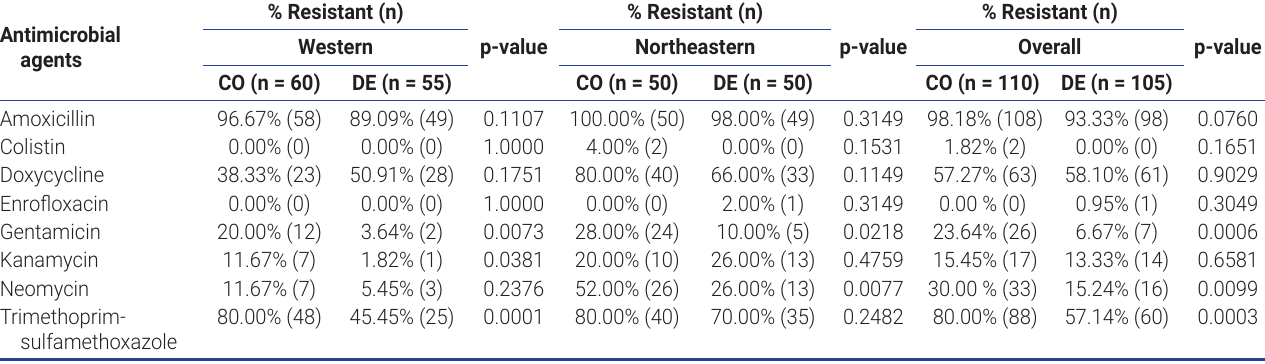
Table 2. Percentages of antimicrobial-resistant Escherichia coli between the conventional system (CO) and the deep litter system (DE) in the cur- rent study Antimicrobial agents